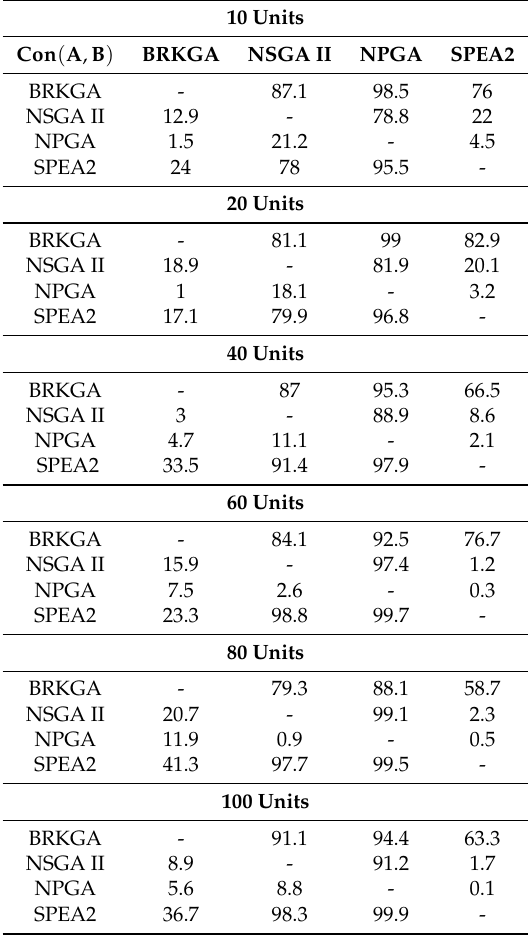
Table 11. Contribution measure